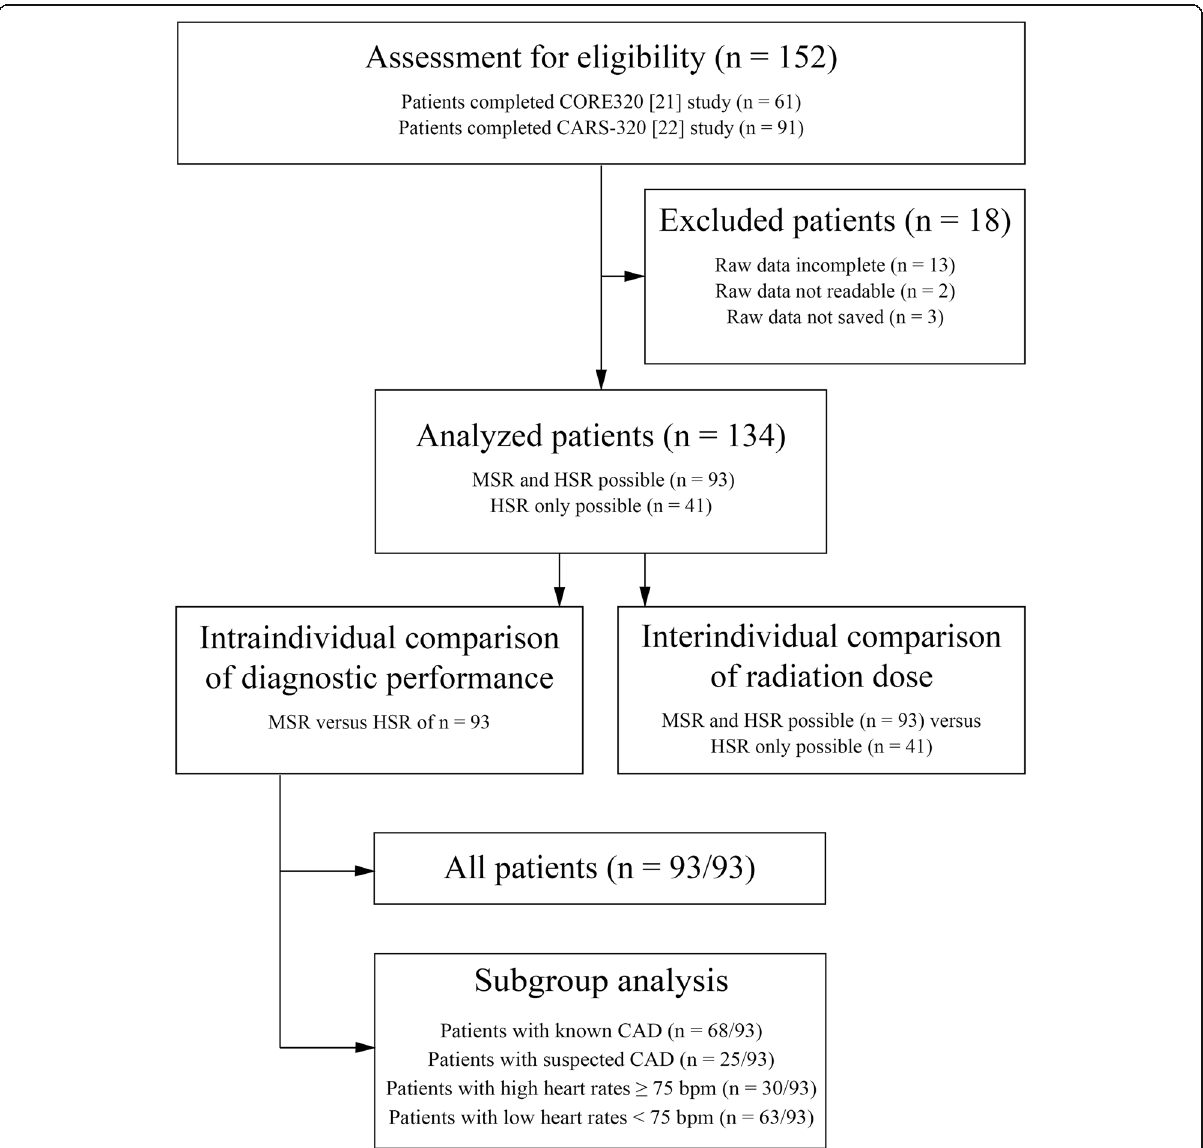
Fig. 1 Flow chart showing the patient selection strategy for comparison of diagnostic performance and radiation dose of MSR and HSR of myocardial CTP imaging datasets in patients with suspected or known CAD. The study population for intraindividual comparison of diagnostic performance consisted of 93 of 134 patients with multisegment acquisition of stress CTP allowing both HSR and MSR. The remaining 41 of 134 patients had predefined single-segment acquisition due to heart rates <65bpm, and only HSR was possible. These patients served as a control group for interindividual radiation dose comparison. bpm Beats per minute, CAD Coronary artery disease, CTP Computed tomography perfusion, HSR Halfscan reconstruction, MSR Multisegment